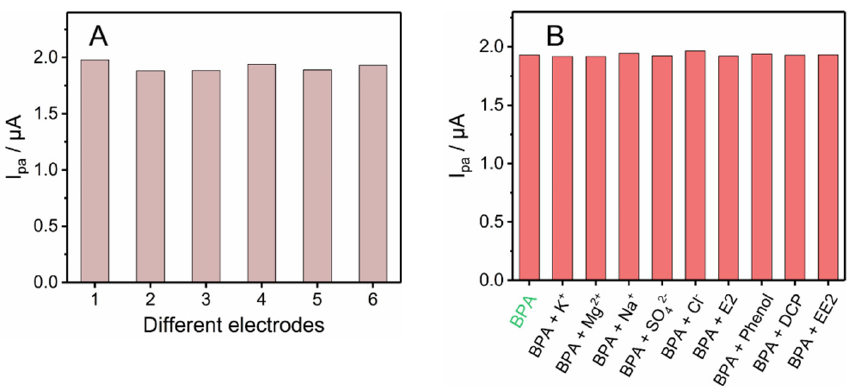
Figure 7. ( A ) Reproducibility of ZnO/BC sensor for 20 µ M BPA detection. ( B ) Oxidation peak currents of 20 µ M BPA at the ZnO/BC electrode in the presence of 100-fold anions, cations and the same concentration of estradiol (E2), phenol, dichlorophenol (DCP) and ethinylestradiol (EE2).